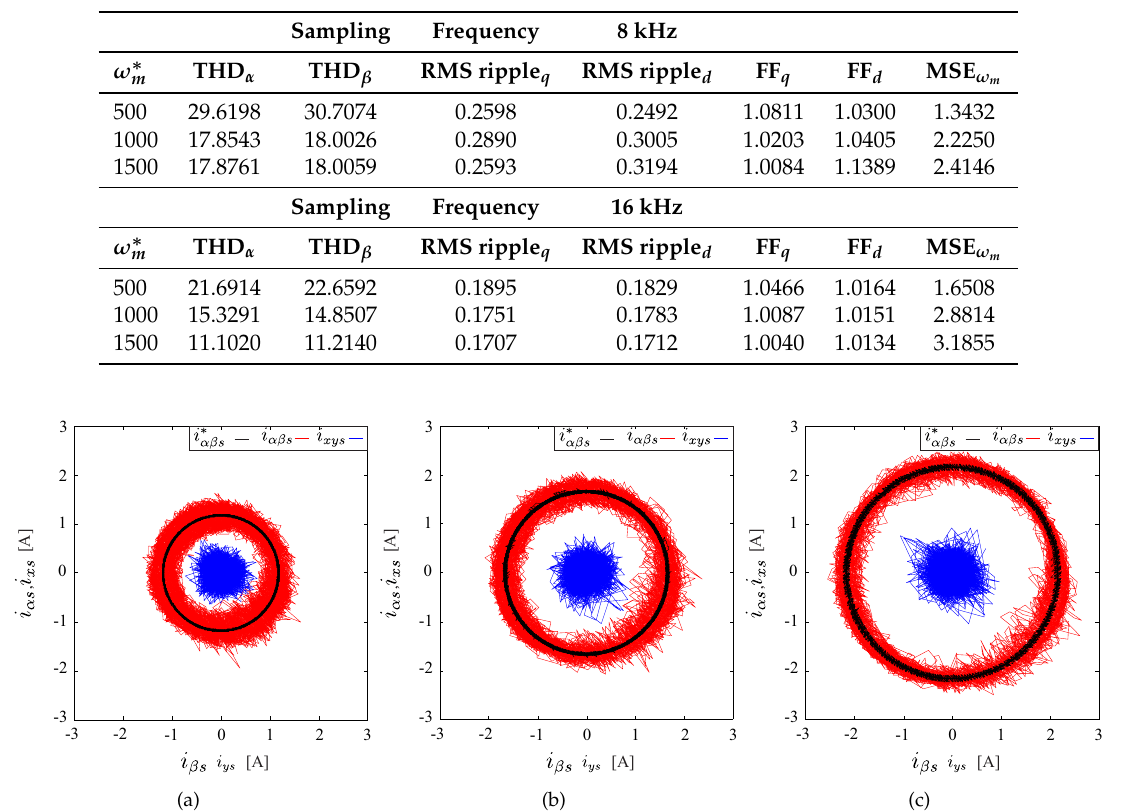
Table 3. Performance analysis of stator current α − β , THD (%), d − q , RMS ripple (A), FF, rotor speed ( ω m ) and MSE (rpm) at different rotor speeds (rpm).